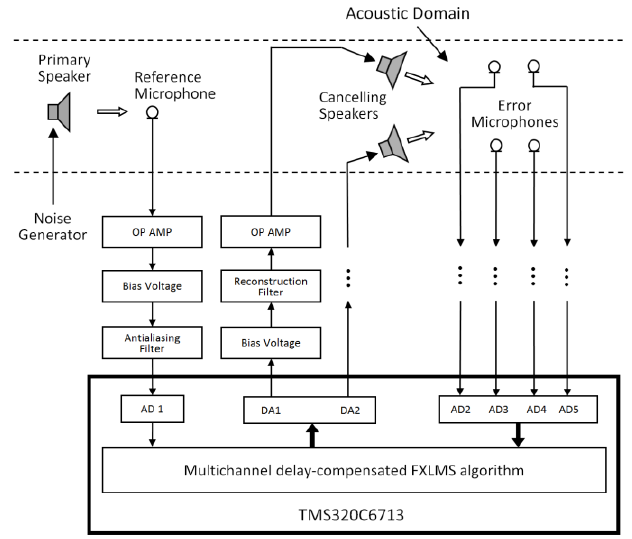
Figure 2. The structure of multichannel real-time active noise control (ANC) system.